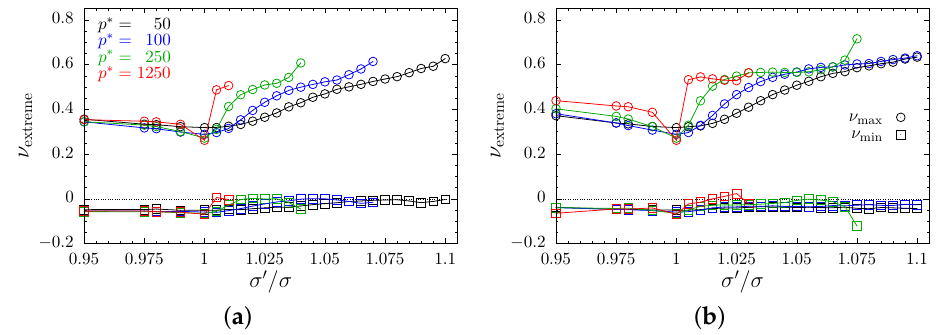
Figure 9. Extreme PR values for systems with ( a ) D -type and ( b ) S -type crossing nanochannels, plotted with respect to scaling factor σ (cid:48) / σ . Values for maximal and minimal PR have been marked with sphere and square symbols, respectively. Results obtained for different values of the reduced external pressure p ∗ have been indicated in